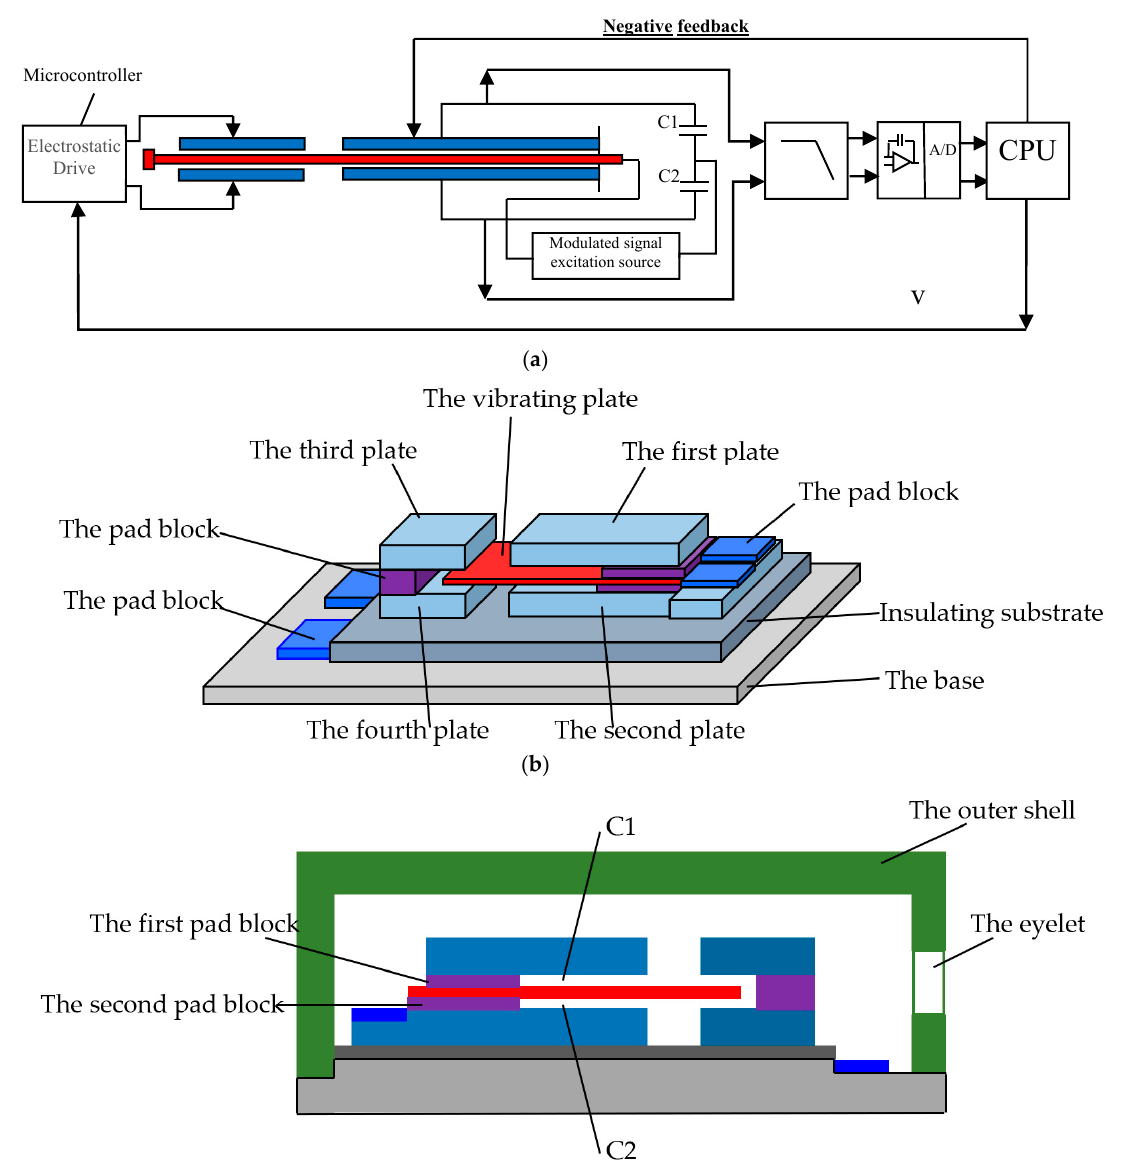
Figure 2. The sensor model with negative stiffness: ( a ) schematic diagram of sensor structure design; ( b ) the 3D structures of capacitive sensor with negative stiffness; ( c ) the 2D structures of capacitive sensor with negative stiffness.